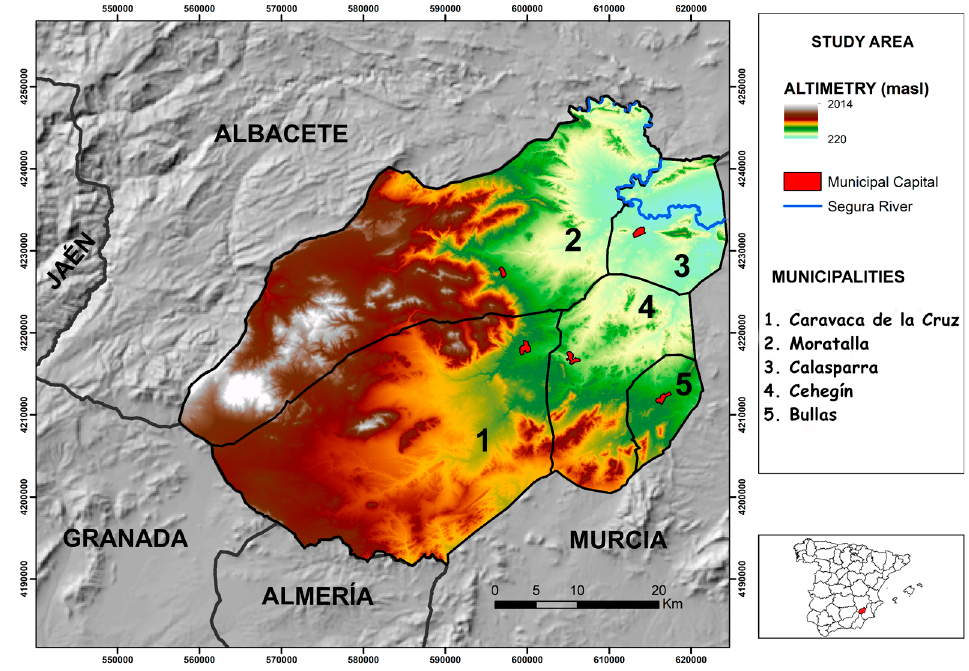
Figure 2. Study area. The northwest Region of Murcia: altimetry, hydrographic network, municipal and provincial limits. Source: Authors.